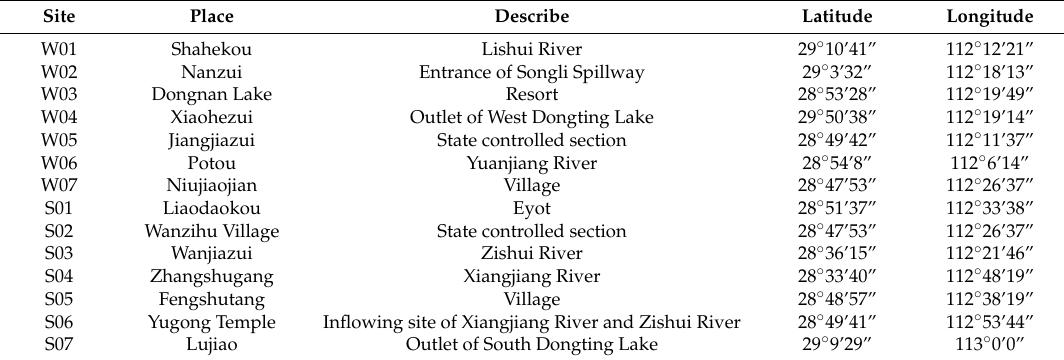
Table 1. Information of each lakeshore sites in this